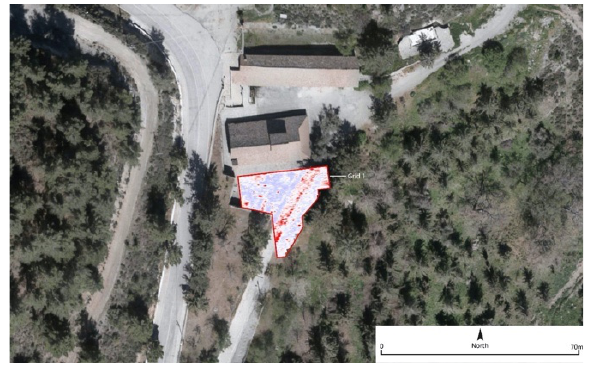
Figure 11. Panagia tou Araka, Lagoudhera, GPR survey.